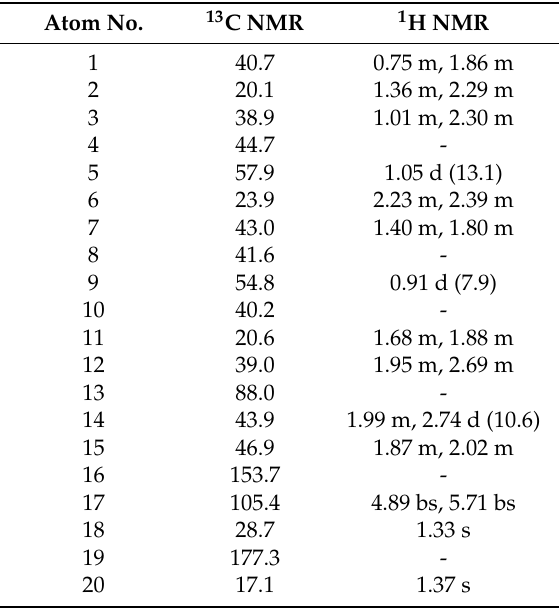
Table 1. 1 H and 13 C Nuclear Magnetic Resonance (NMR) (500 and 125 MHz, 300 K) assignments of the aglycone of compound ( 1 ) in pyridine- d 5 . Atom No. 13 C NMR 1 H